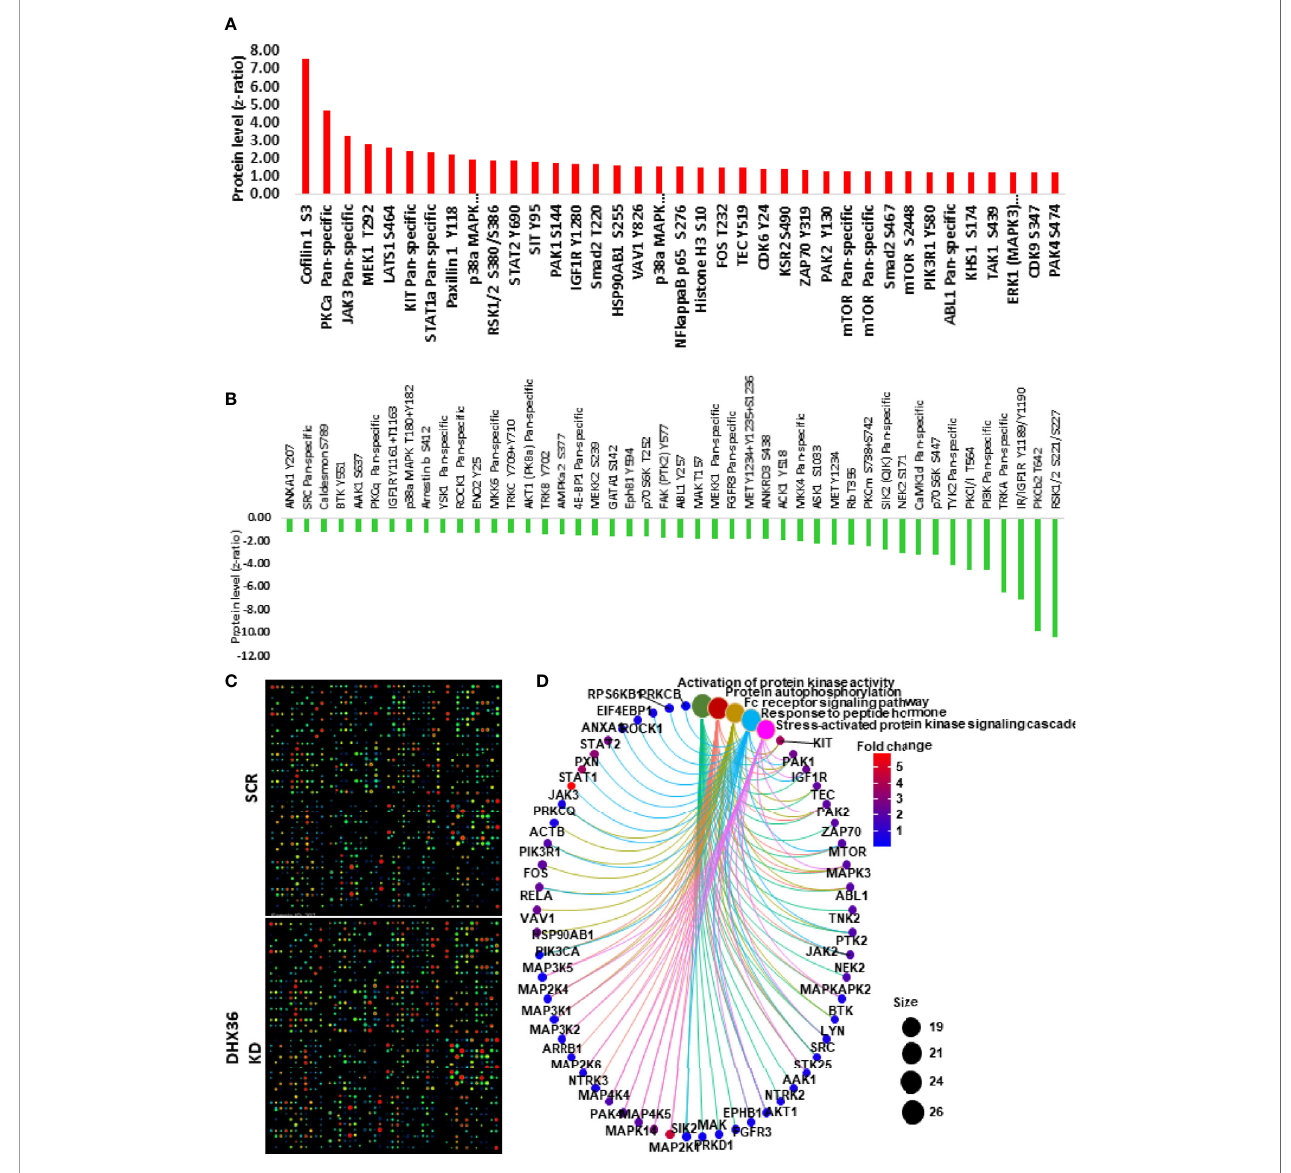
FIGURE 6 | Kinex antibody microarray analysis of signal transduction after DHX36 was knocked down in A549 cells. (A) Upregulated proteins with z ratio>1 (B) Downregulated proteins with z ratio<-1 (C) Heatmaps of the Kinex antibody arrays. (D) Key signalling pathways identi fi ed using the clusterPro fi ler Bioconductor package in R